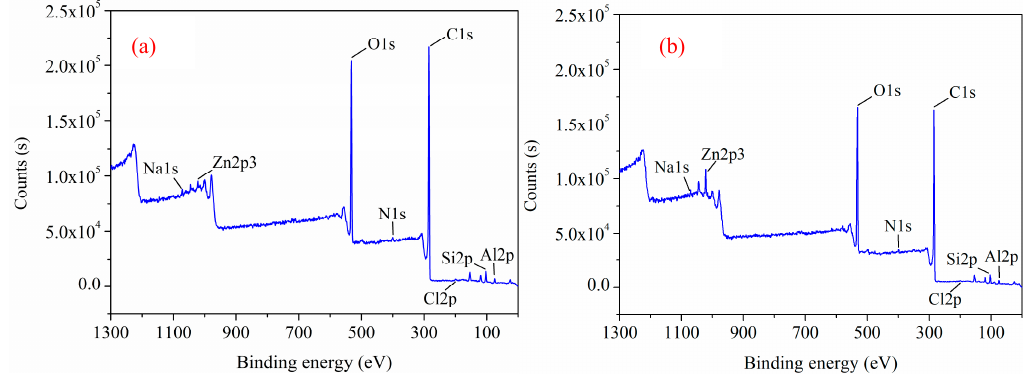
Figure 7. X-ray photoelectron spectroscopy (XPS) spectrum of different comminution products; ( a ) rod-milled products, ( b ) crushed products. Table 1. Atomic ratios of different comminution products.